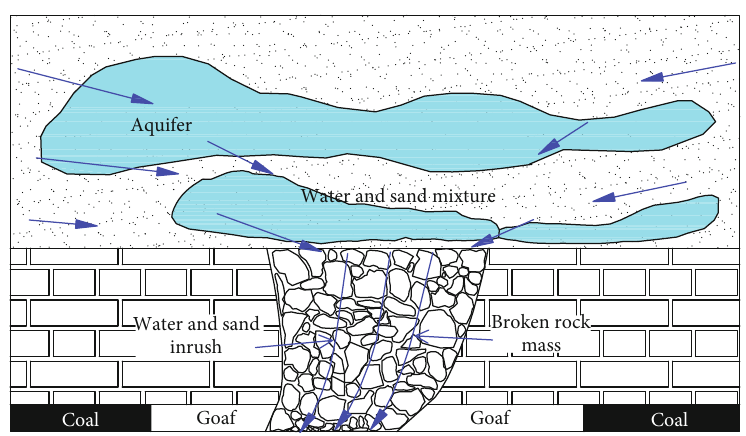
Figure 1: Schematic of a water and Aeolian sand